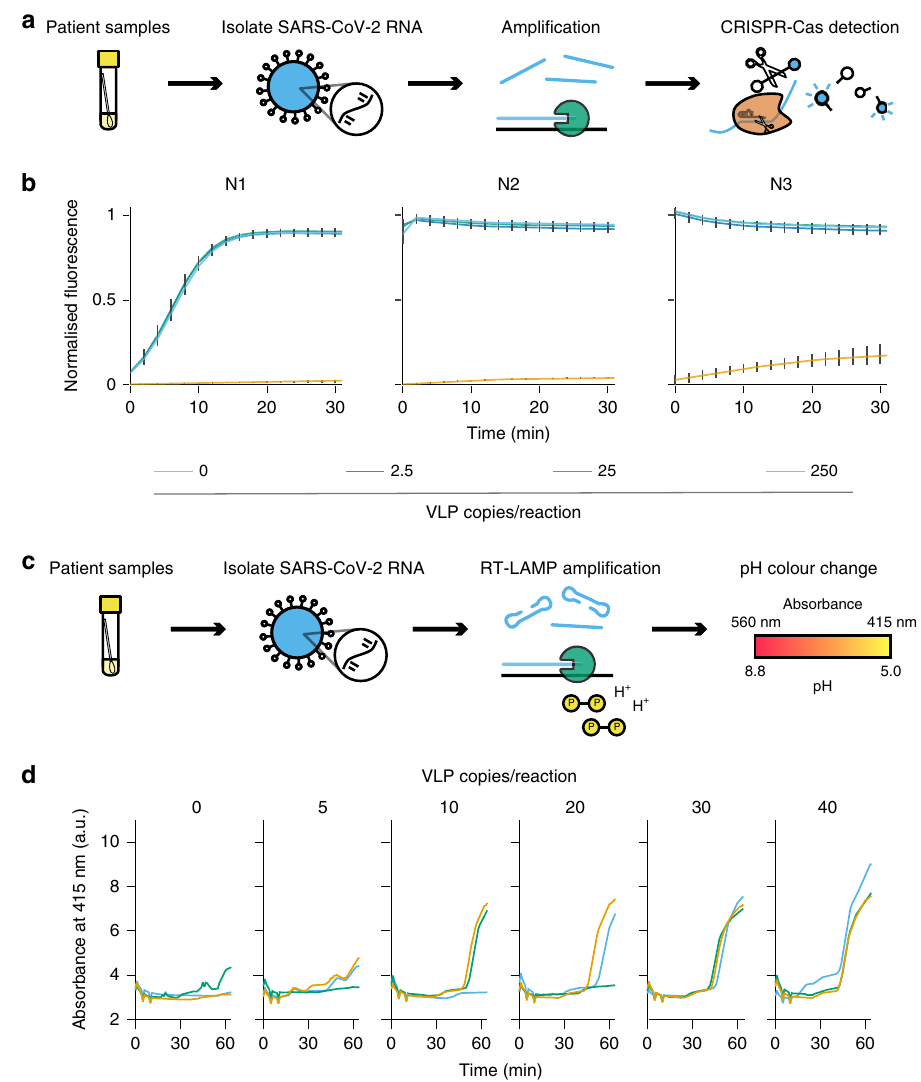
Fig. 3 SARS-CoV-2 N-gene target RNA detection by CRISPR-Cas13a and RT-LAMP diagnostic systems. a Schematic of the CRISPR-Cas13a nucleic acid detection work fl ow from patient samples. Viral RNA is ampli fi ed using target-speci fi c primers and detected with target-speci fi c crRNA activating Cas13a to collaterally cleave a fl uorescent probe. b CDC N1, N2, and N3 primer sets were employed to amplify the N-gene RNA released from MS2-SARS-CoV-2 VLPs at 2.5, 25, and 250 copies per reaction. The CRISPR-Cas13a detection time course was analysed using a fl uorescence microplate reader. Error bars represent the SEM of n = 3 biologically independent ampli fi cation reactions and four CRISPR detection technical replicates. c Schematic of the RT-loop- mediated isothermal ampli fi cation (RT-LAMP) diagnostic work fl ow using target-speci fi c LAMP primers. The isothermal ampli fi cation of a target results